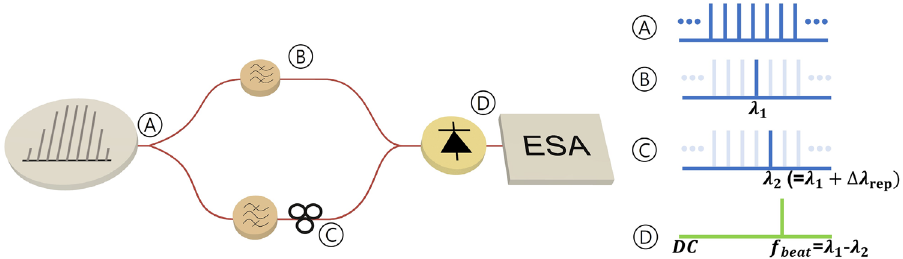
Figure 3. Schematic of phase noise measurement setup. ESA electrical spectrum analyzer.